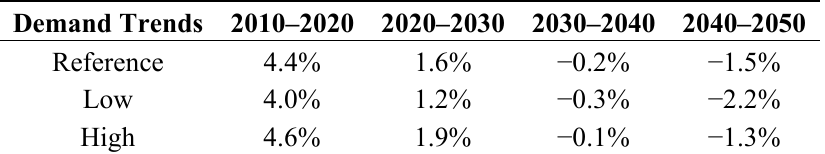
Table 2. Growth rates for industrial energy demand in scenarios.